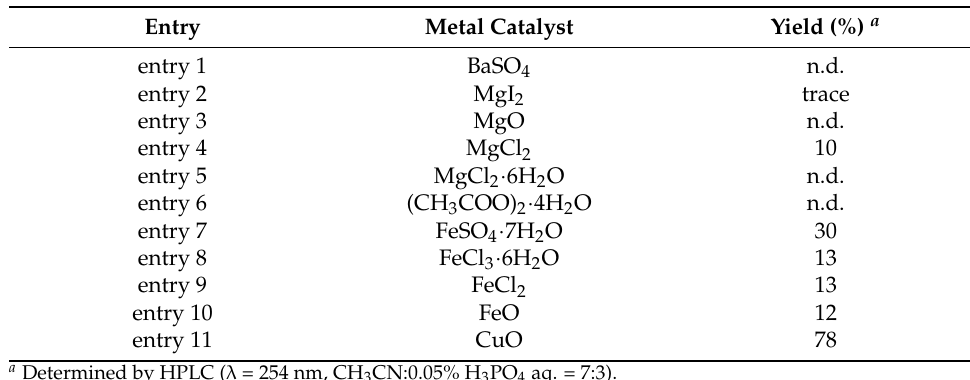
Scheme 3. Oxidation catalyzed by various metal catalyst. Table 1. Catalyst